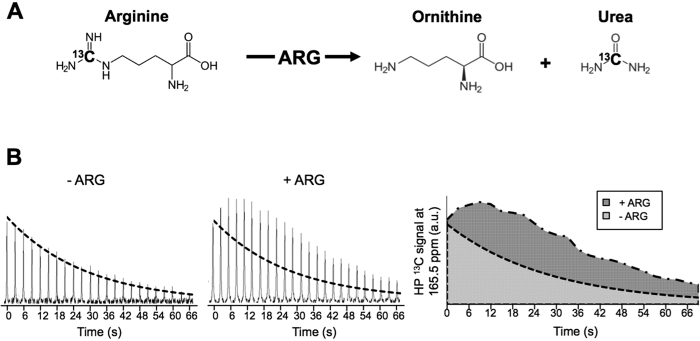
[13C]-urea detection: metabolic conversion and post-processing analysis.(A) Schematic showing the conversion of hyperpolarized [6-13C]-arginine into hyperpolarized [13C]-urea and ornithine by ARG. The 13C labeled carbon is highlighted in bold. (B) Mono-exponential decay (doted curve) depending on measured hyperpolarized 13C-contaminant T1 and flip angle was subtracted from all data allowing detection of urea production when ARG is present.